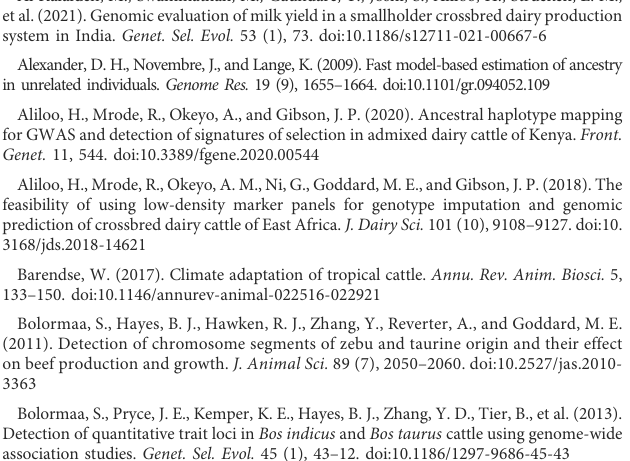
SUPPLEMENTARY FIGURE S1 DistributionofallelefrequenciesofSNPofindigenousorigin (A) ,ofHForigin (B) and of Jersey origin (C) using three-way ancestral assignment. SUPPLEMENTARY FIGURE S2 Manhattan plot of GWAS (Model 3b) for indigenous versus HF origin using SNP alleles of indigenous origin that had a MAF > 1% when SNP allele of HF and Jersey origin had a MAF < 1%. SNP that passed the FDR threshold of 5%, 10%, 20%, and 30% are highlighted in red, orange, green, and blue, respectively. SUPPLEMENTARY FIGURE S3 Manhattan plot of GWAS (Model 4b) for indigenous versus Jersey origin using SNP alleles of indigenous origin that had a MAF > 1% when SNP allele of HF and Jersey origin had a MAF < 1%. SNP that passed the FDR threshold of 5%, 10%, 20%, and 30% are highlighted in red, orange, green, and blue, respectively. SUPPLEMENTARY FIGURE S4 ManhattanplotofGWAS(Model3a)forindigenousversusHForiginusingSNP allele of HF and of Jersey origin that had a MAF > 1% when SNP alleles of indigenous origin had a MAF < 1%. SNP that passed the FDR threshold of 5%, 10%, 20%, and 30% are highlighted in red, orange, green, and blue,